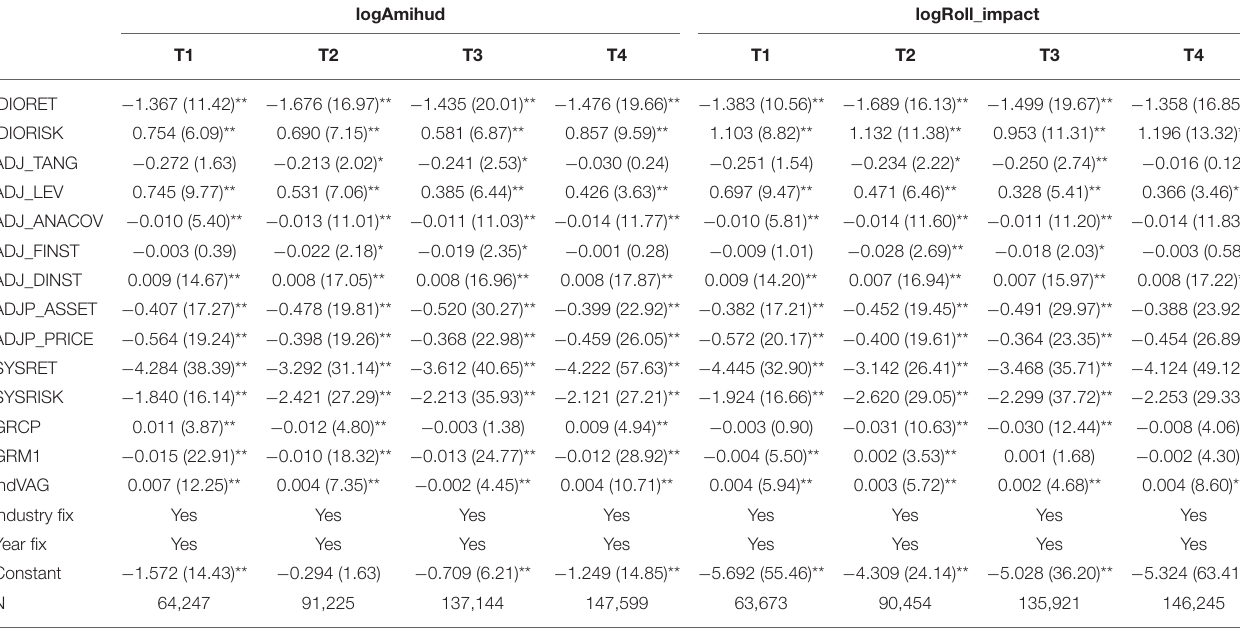
TABLE 7 | One-month-forward prediction of Amihud’s illiquidity ratio and Roll’s price impact over four sub-periods. logAmihud